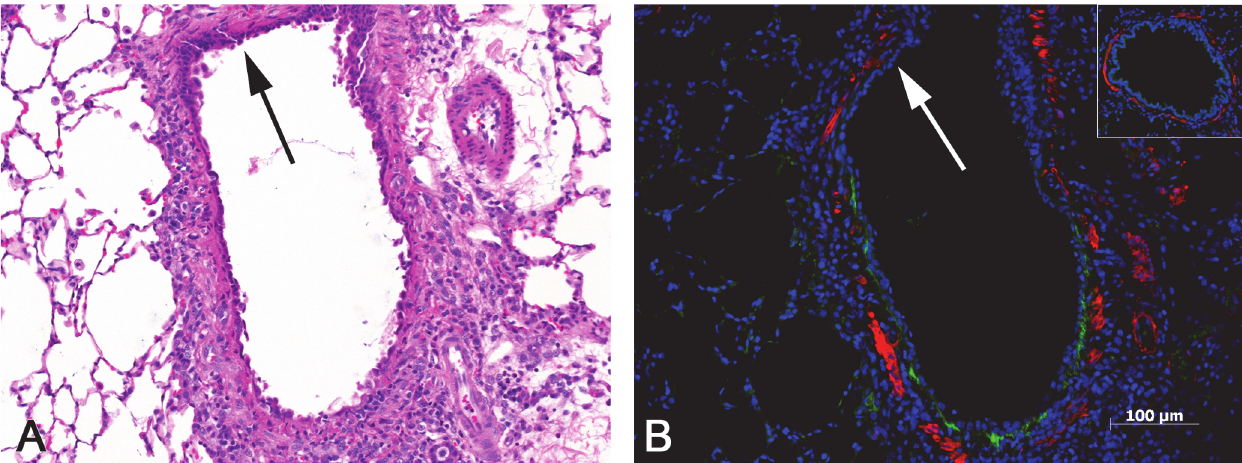
Fig 6. Inflamed, non-fibrotic bronchus with tenascin C expression. A) This bronchus shows no evidence of fibrosis, but exhibits a mild infiltrate of mononuclear cells and is lined by an attenuated epithelium with a reactive and regenerative appearance. Absence of inflammation in the upper portion of bronchus (arrow). H&E, 10x original objective magnification. B) Early tenascin C expression is indicated by the linear green band located just beneath the epithelial lining. Note that there is no tenascin C expression in the upper portion of the bronchus (arrow), in which there is little or no inflammation and less attenuation of the epithelial lining (compare to A). The inset shows a bronchus from one of the control lungs, with absence of any tenascin C expression. Immunofluorescent stains were used to label tenascin C (green) and smooth muscle actin